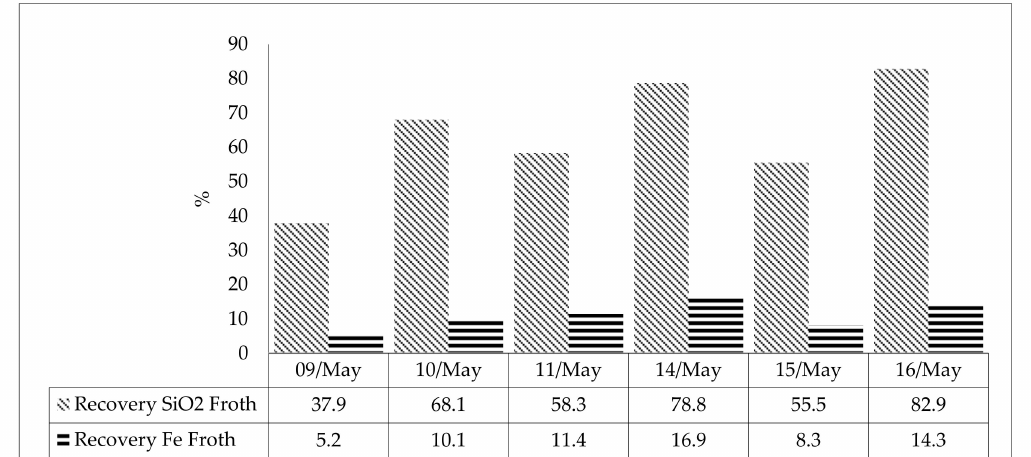
Figure 13. Recovery of SiO 2 and Fe to the